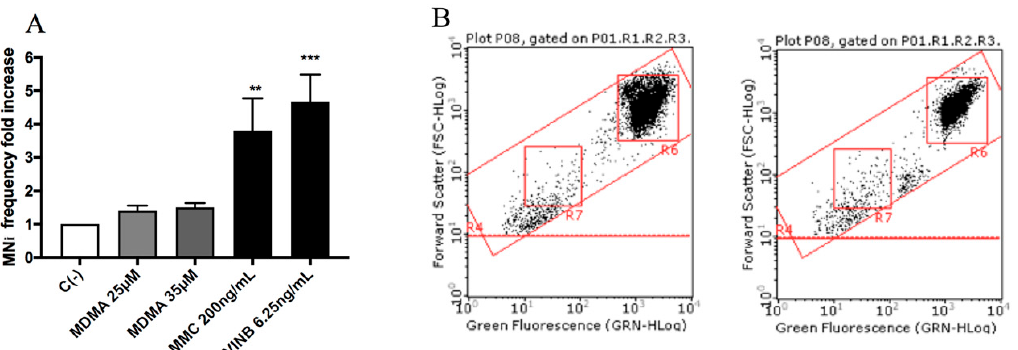
Figure 8. MNi frequency fold increase on TK6 cells after 26 h treatment with MDMA at the indicated concentrations with respect to the untreated negative control C (-) and to positive controls [MMC and VINB]. ( A ) A plot of the nuclei and MNi in the untreated control ( B , left) and in 35 µ M MDMA-treated cultures ( B , right). Each bar represents the mean ± SEM of five independent experiments. Data were analysed using repeated ANOVA followed by Bonferroni post-test. ** p < 0.01 vs. C (-); *** p < 0.001 vs. C